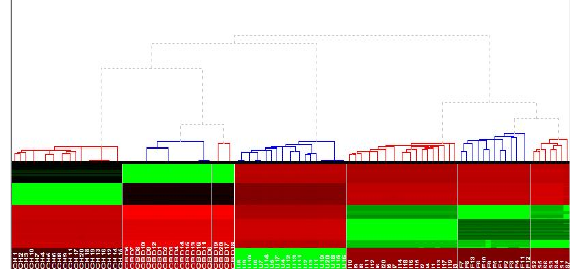
Fig. 3. Clustered result which is extracted by proposed method with minimum distance score (0.295) of 50 trajectories.